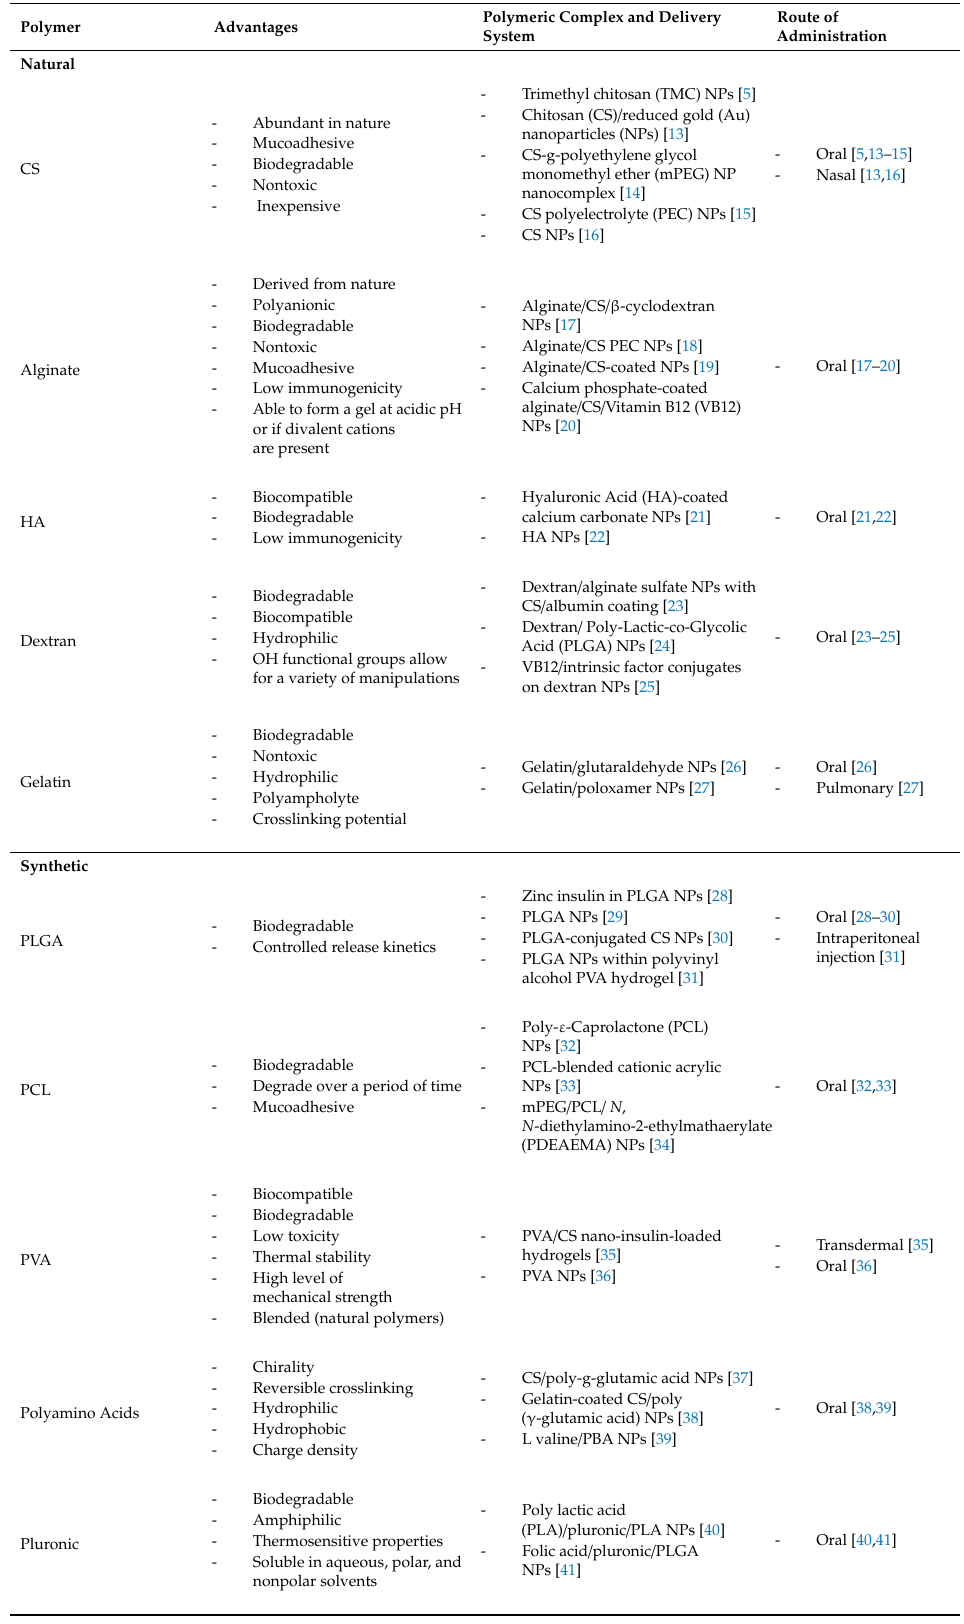
Table 1. Summary of natural and synthetic polymers, their advantages, polymeric complexes, delivery systems, and alternative routes of administration employed in nano-insulin delivery. NPs: